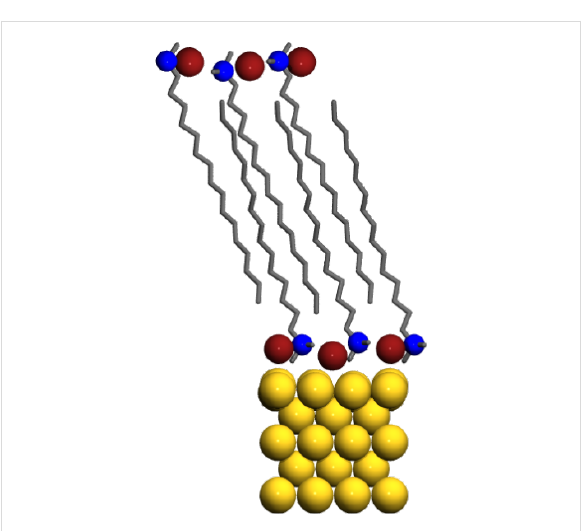
Figure 3: Schematic representation of the adsorption of a surfactant on a gold surface. Spheres represent gold (yellow), silver (grey) and bromine (red) and the tails of the surfactant are represented by